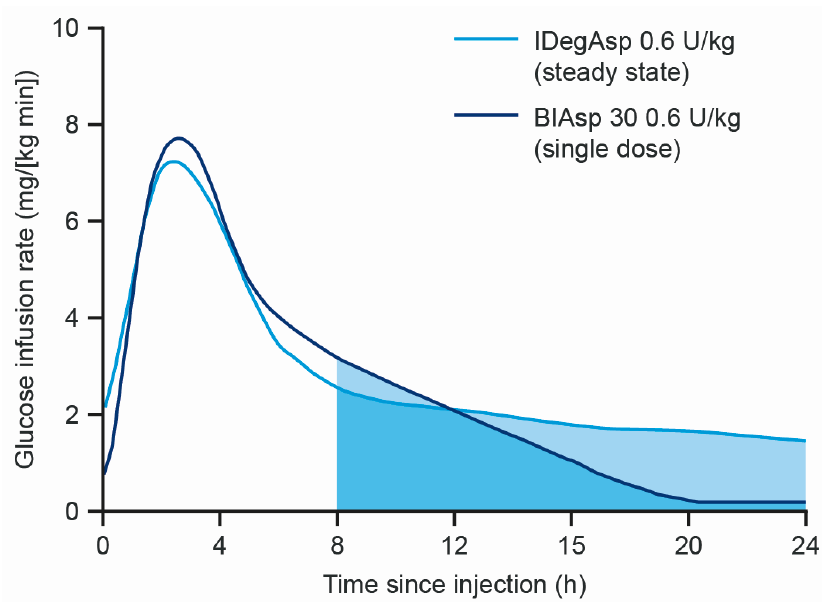
Figure 1. Comparison of the mean glucose infusion rate of IDegAsp and BIAsp30 in subjects with T1D [19]. BIAsp 30, biphasic insulin aspart 30/70; IDegAsp, insulin degludec/insulin aspart co-formulation; T1D, type 1 diabetes; U, units.